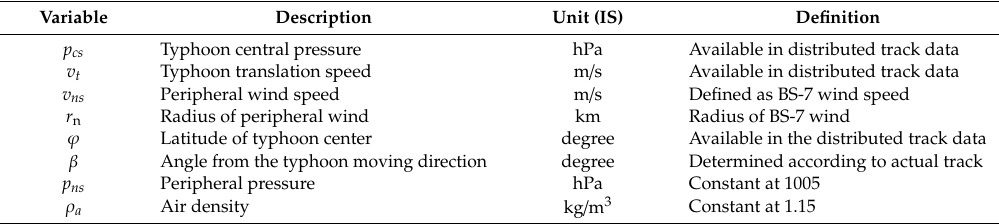
Table 2. Variables to run modified H10